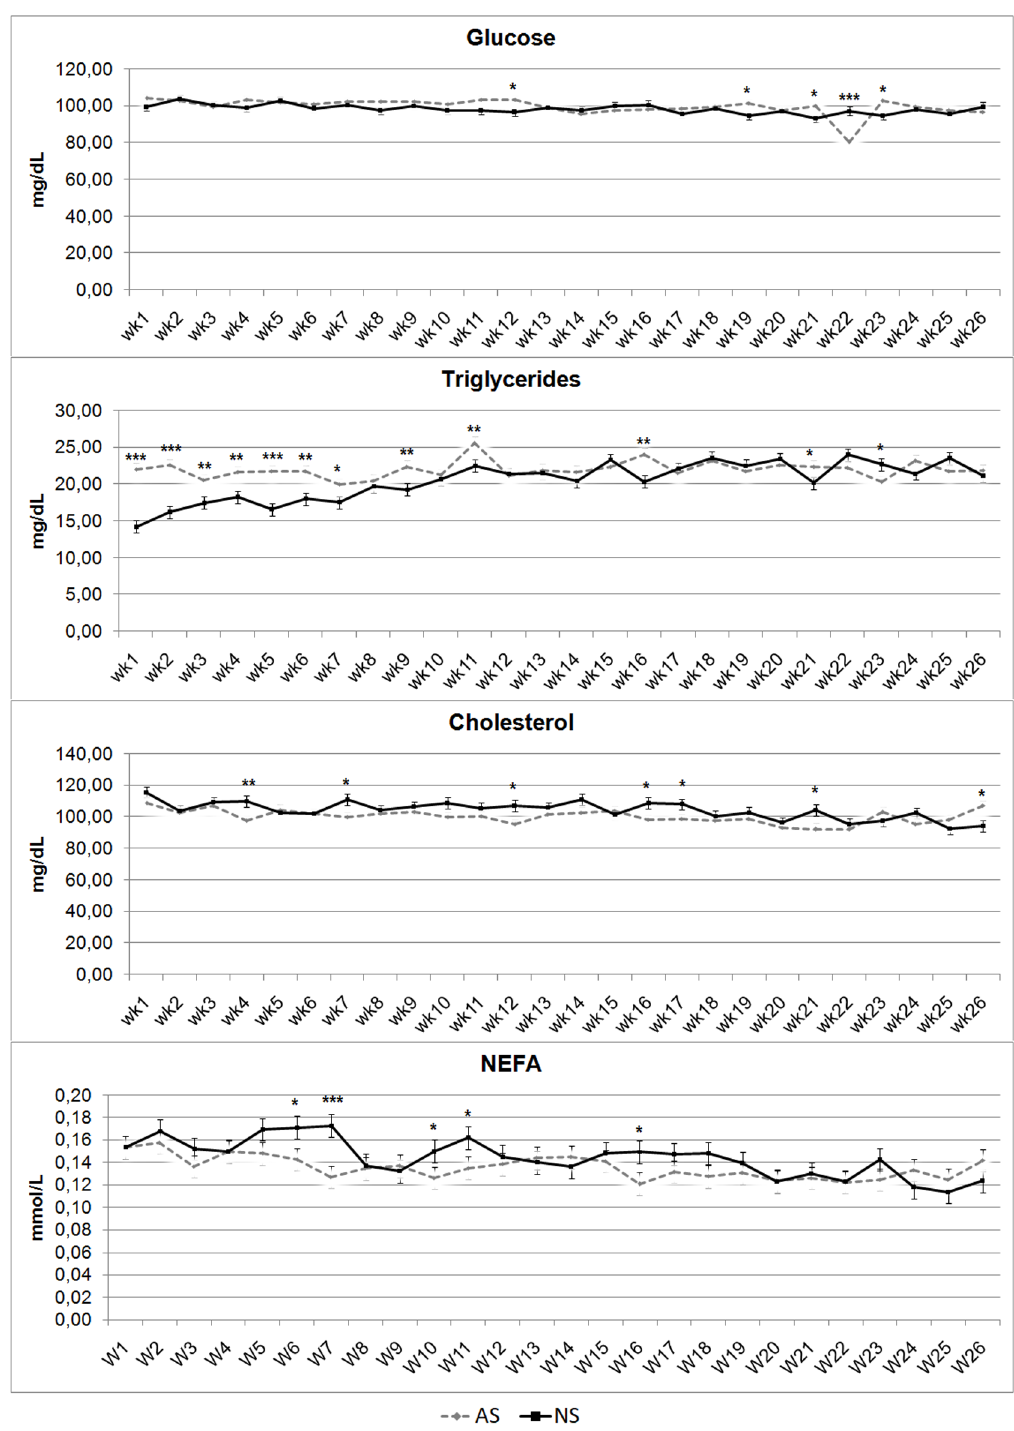
Fig 5. Glucose, triglycerides, cholesterol and non-esterified fatty acids (NEFA) serum concentrations in artificially-suckled (AS) and naturally-suckled (NS) donkey foals during the first 26 weeks of life.(Values are Least Square Means; bars represents Standard Error of the Mean). Statistical differences between the two groups at the same week were expressed: (cid:3) = P < 0.05; (cid:3)(cid:3) = P < 0.01; (cid:3)(cid:3)(cid:3) = P < 0.001.